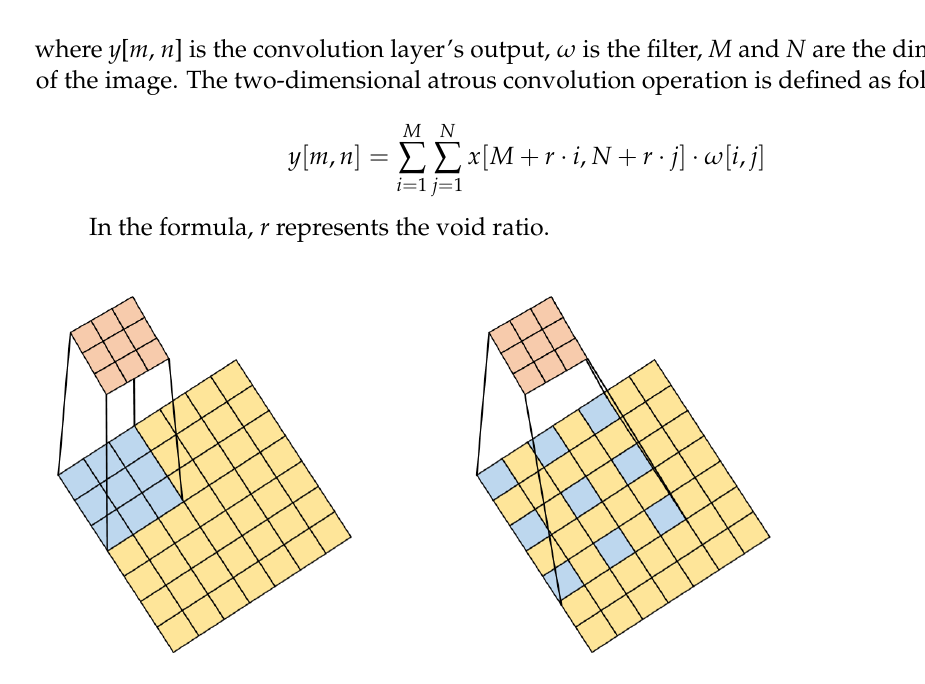
Figure 5. Atrous convolution